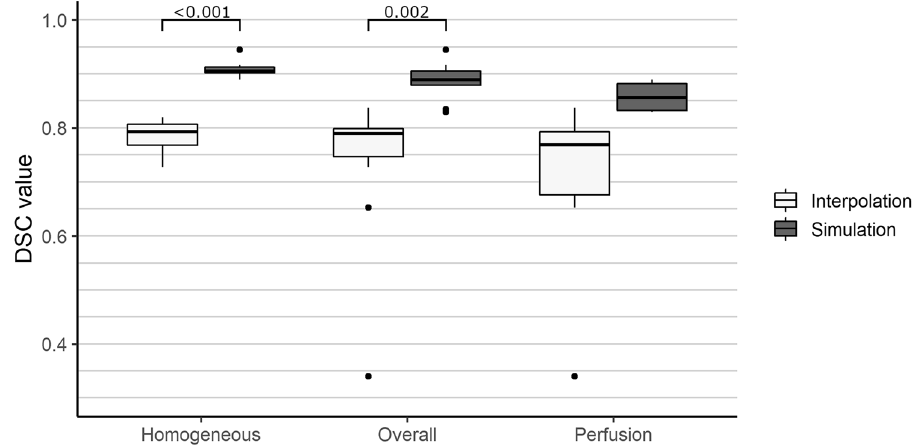
Figure 4. Results of the similarity measurements. The DSC is separated for each phantom category with: Homogeneous = Phantoms without PVC tubes and water perfusion (n = 7). Perfusion = Phantoms with PVC tubes and water perfusion (n = 6). Overall = All phantoms (n = 13). Horizontal lines indicate statistically significant post-hoc pairwise t-test results. No values are located below a DSC of 0.3.